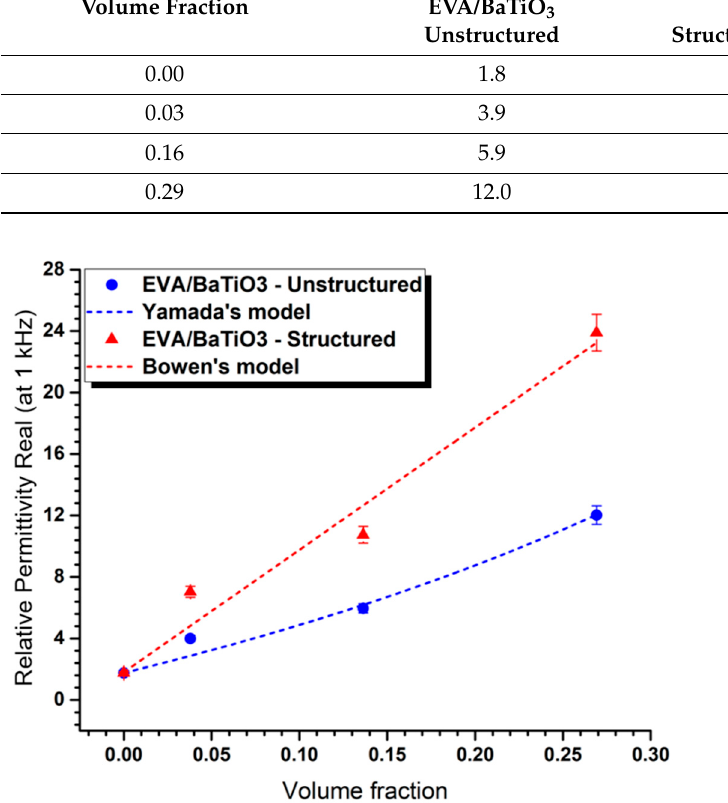
Figure 7. Experimental permittivity values for both structured and unstructured composites compared with Yamada (0–3 connectivity) and Bowen’s (1–3 connectivity) models. Table 2. Relative dielectric permittivity at 1 kHz, as a function of BaTiO 3 volume content for unstructured 0–3 configuration, and dielectrophoretically structured 1–3 configuration.